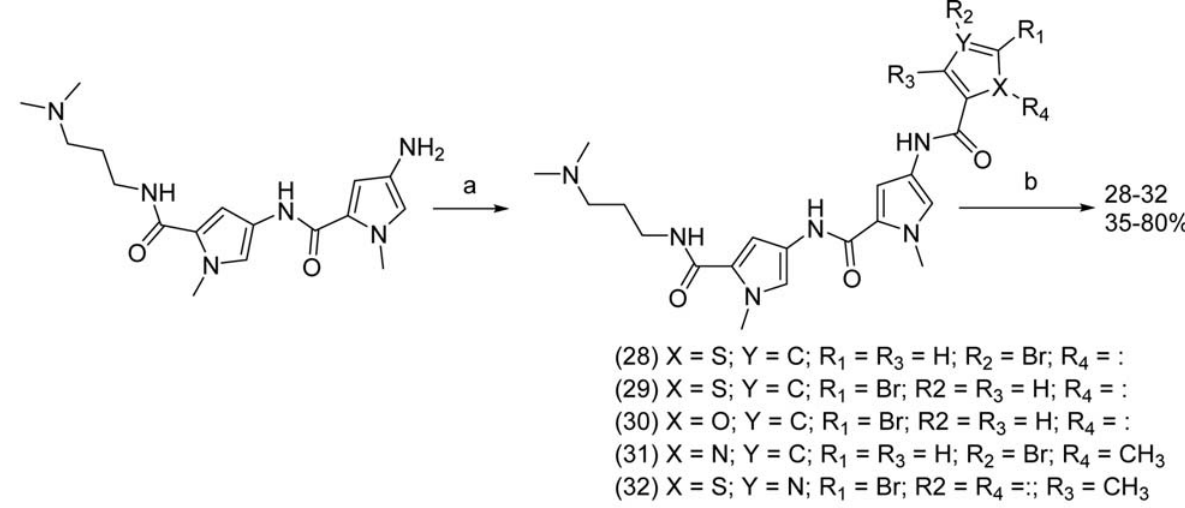
Scheme 7. General synthetic scheme for the synthesis of the biaryl containing MGBs (a) HOBt, DIC, 16 h, rt; (b) Pd(PPh (for more details see reference